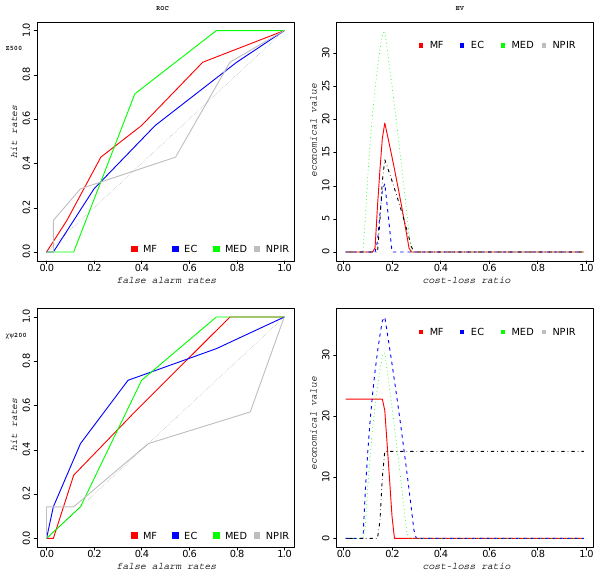
Fig. 8. HPE ROC curves (left; false alarm rates in abscissa, hit rates in ordinate) and Economical Value curves (right, cost-loss ratio in abscissa, economical values in ordinate) for the MOS LRM method- ology; Z500 (top), χψ 200 (bottom), from each forecast set.